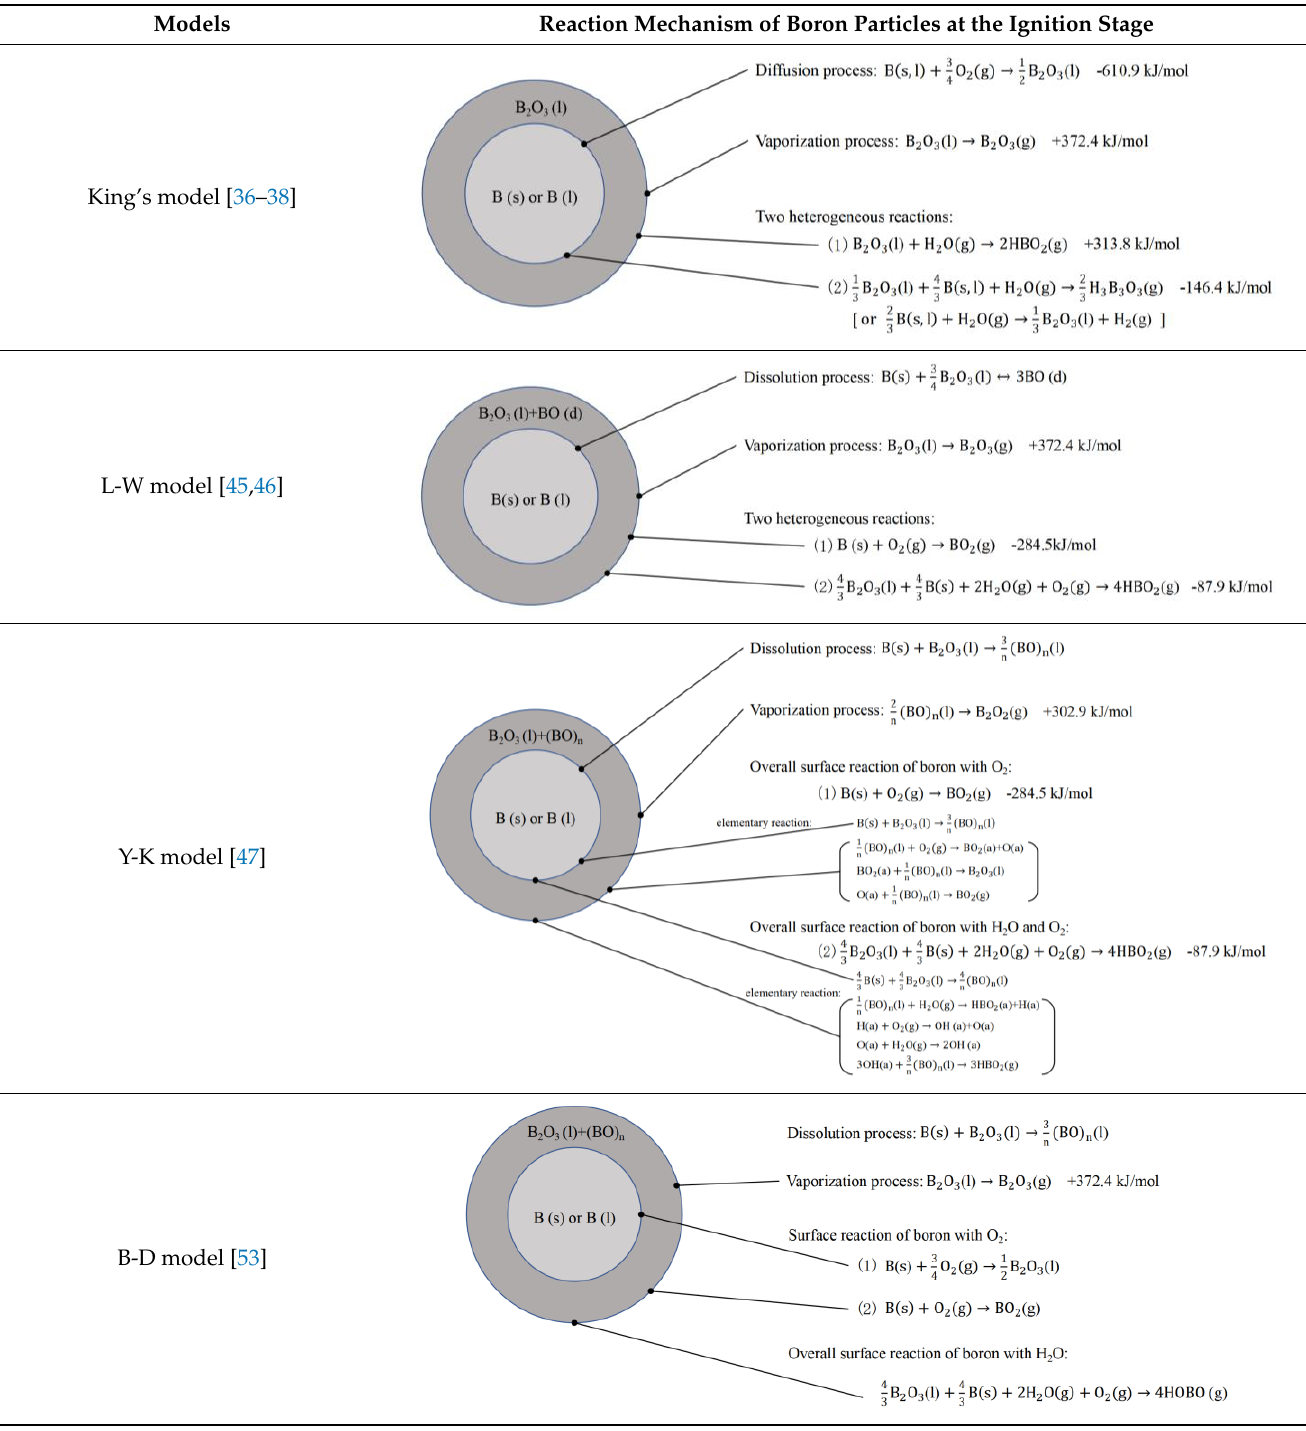
Table 1. Four ignition models of boron particles.